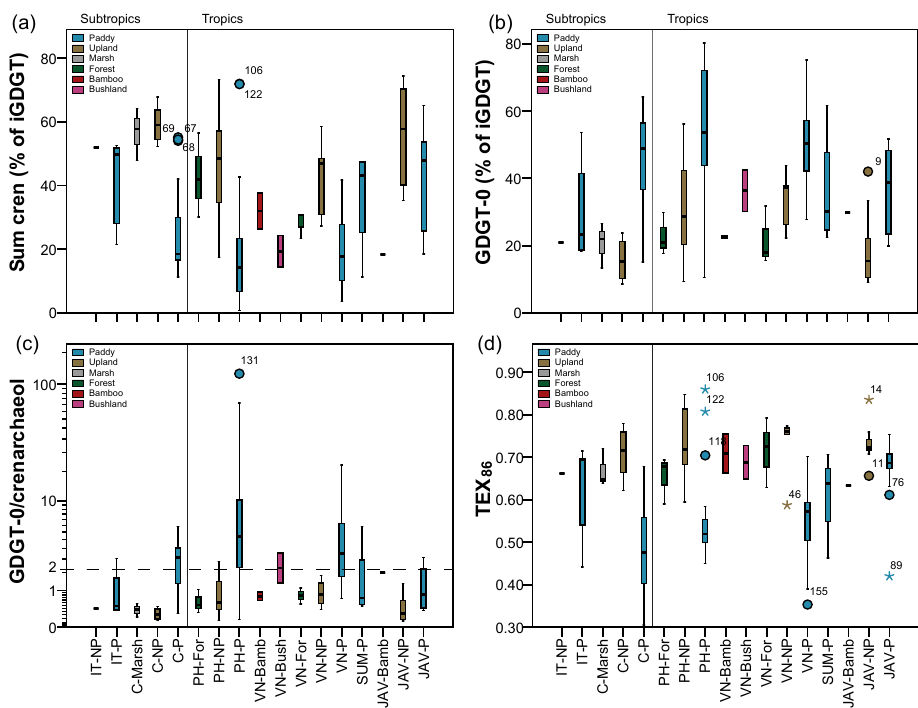
Figure 2. Box-plot diagrams of (a) crenarchaeol, (b) GDGT-0, (c) GDGT-0 / crenarchaeol ratio and (d) TEX 86 in upland (NP, brown), paddy (P, blue), marsh (grey), forest (For), bamboo cultivated (Bamb, red) and bushland (Bush, violet) soils. Abbreviations refer to different sampling locations: Italy (IT), China (C), Philippines (PH), Vietnam (VN), Sumatra (SUM) and Java (JAV). The vertical line separates subtropical from tropical locations. Numbers in all plots indicate samples listed in Table S1. The dashed line in (c) marks the GDGT- 0 / crenarchaeol value of 2 that is the boundary to higher proportions of methanogens, which reveal values >2. Note the logarithmic scale for GDGT-0 / crenarchaeol ratios. Note different symbols (circle or asterisk) for outliers that are more than 1.5 (or 3) box lengths from one hinge of the